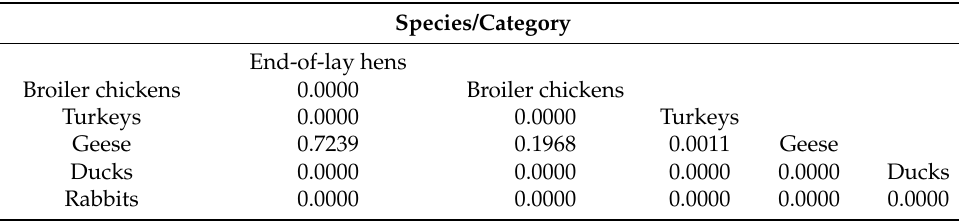
Table 3. The pairwise comparisons ( p -value) of frequency of traumatic injuries to the trunk in monitored animal species and categories.